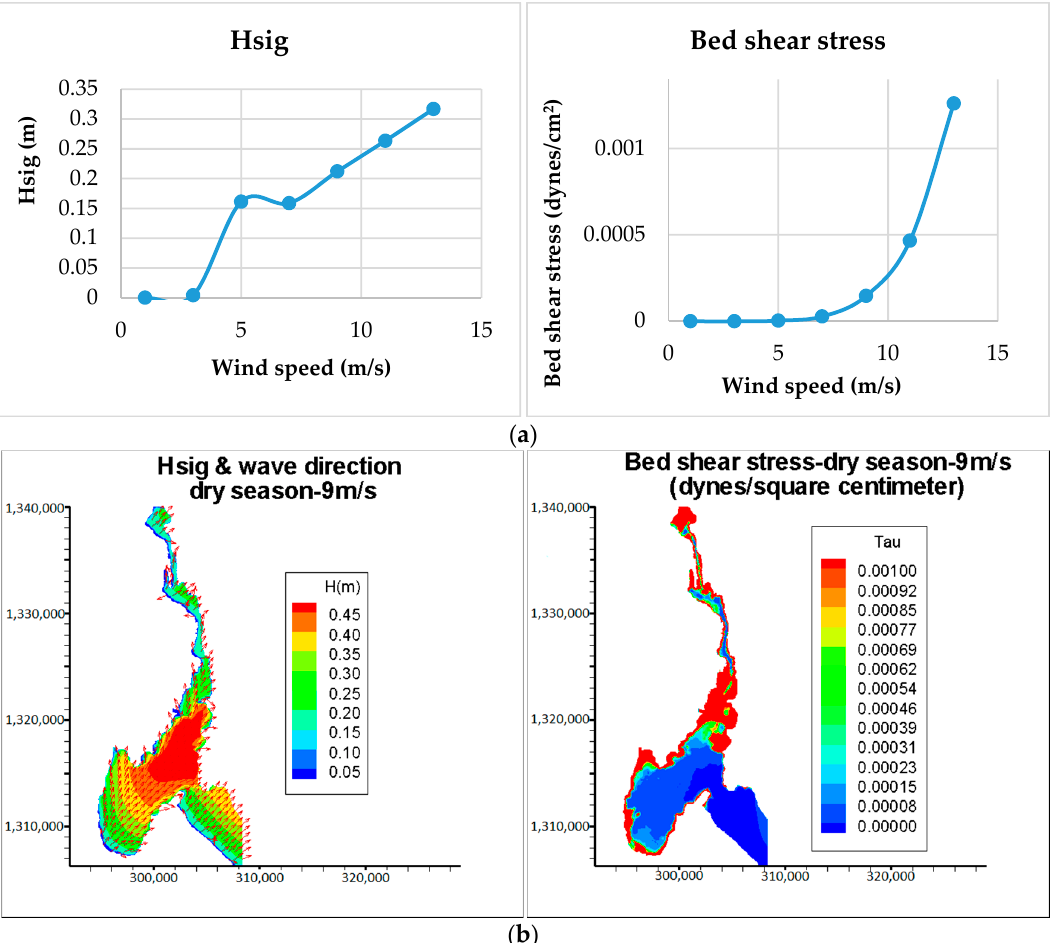
Figure 10. Comparison between observed and estimated (NCEP) wind speeds at 10 m height.